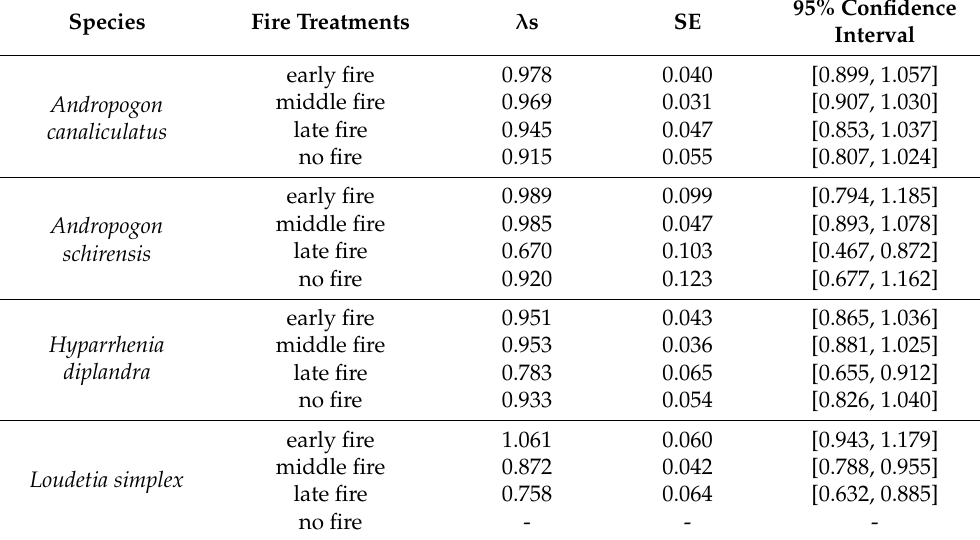
Table 1. Asymptotic grow rates ( λ s), the associated standard errors (SE) and 95% confidence intervals calculated for the mean transition matrix of the four species in each fire treatment. The ( − ) denote that there was no value for L. simplex in the no-fire treatment because there was almost no individual of this species in this